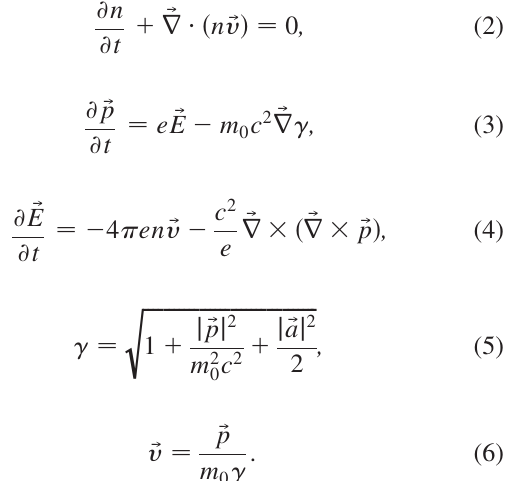
a Plasma length increased by (cid:4) 40% to increase stability against timing fluctuations and allow for longer bunches (needed for increased laser pulse delay and extended plasma length beyond full dephasing